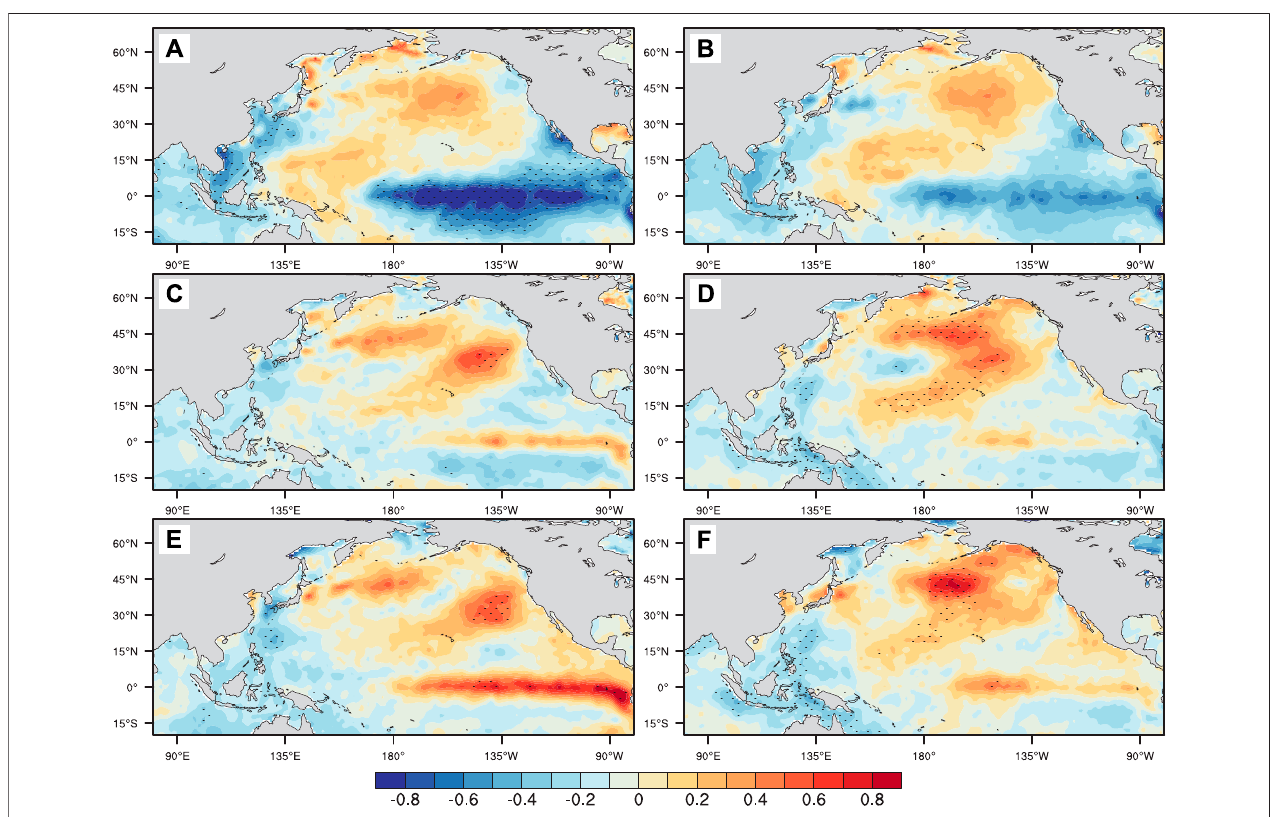
FIGURE9 | Composite ofSST anomalies ( ° C) in (A,B) late winter and early spring (January – March), (C,D) late spring and early summer (May – July),and (E,F) peak season of TC activities (July – September). (A,C,E) : eastern-track type; (B,D,F) : turning type. The dotted areas indicate the anomalies that are signi fi cant at the 95% con fi dence level.